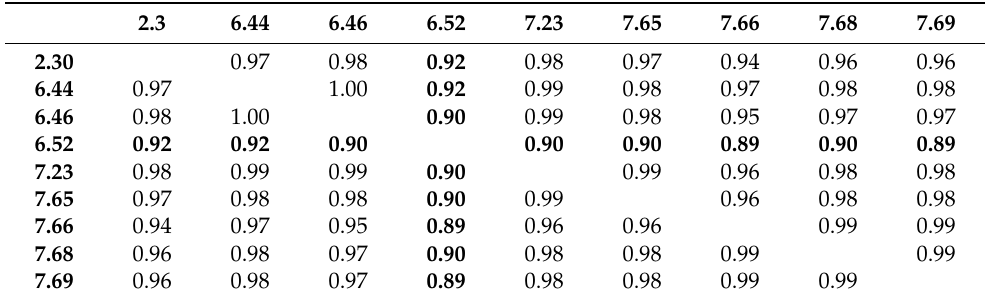
Table 3. Significant buckets (ppm) and their r correlation